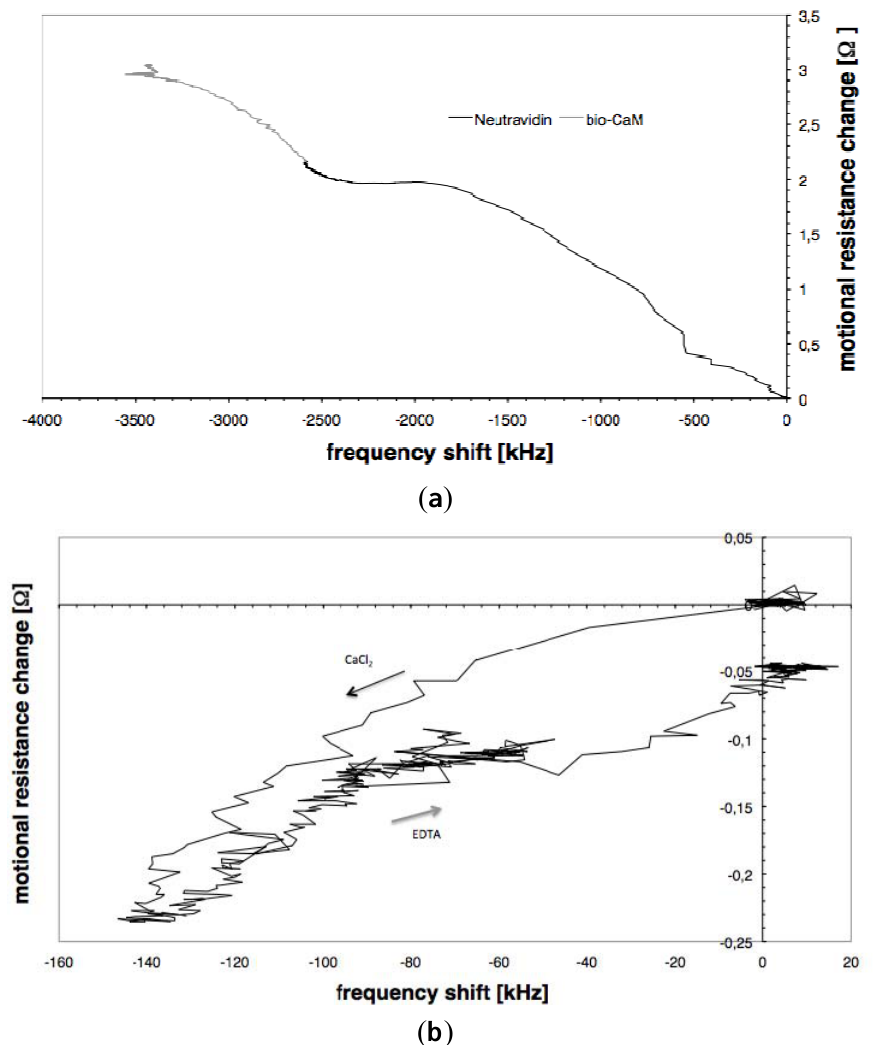
Figure 6. The adsorption of ( a ) Neutravidin and the binding of calmodulin, ( b ) the binding and de-binding of calcium to the calmodulin ( c ) and the peptide binding to the Ca 2+ /calmodulin plotted in resonant frequency versus motional resistance